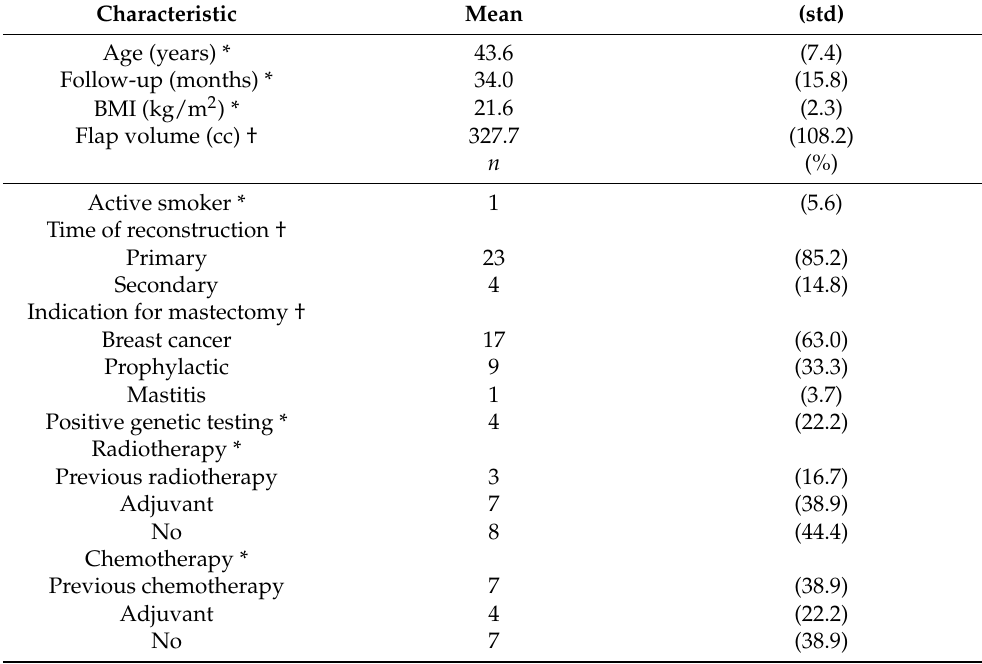
Table 1. Patient characteristics PAP